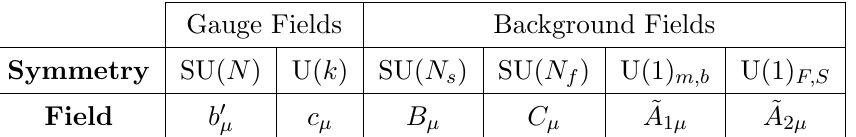
Table 1 . Various gauge (cid:12)elds used in the master duality. Dynamical (cid:12)elds are denoted by lowercase letters while background (cid:12)elds by uppercase. ~ A 1 (cid:22) is associated with the monopole/baryon number U(1) symmetry also present in Aharony’s dualities. ~ A 2 (cid:22) is associated to the U(1) symmetry which couples to the additional fermion/scalar matter in the master